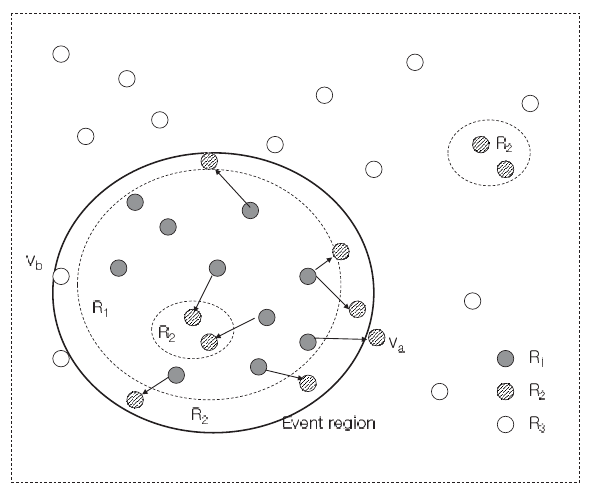
, R and R , using two 1 2 3